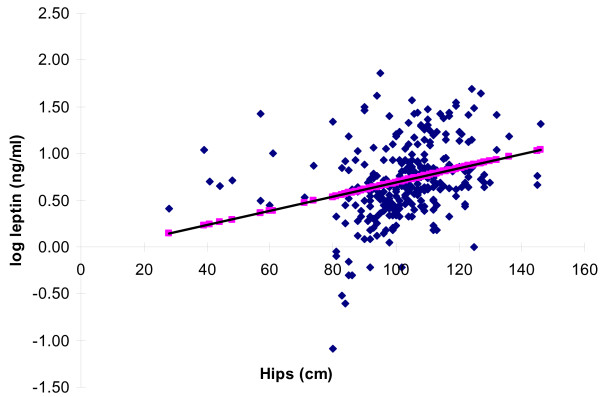
Log leptin (ng/ml) vs. Hip circumference (cm). The correlation of log leptin (ng/mL) with hip circumference (cm) using univariate analysis across all Saudi subjects, case controls, T2DM and pre-diabetic subjects. Blue denotes the actual values with the line of best fit shown in square (R2 0.086 p-value = 0.006).